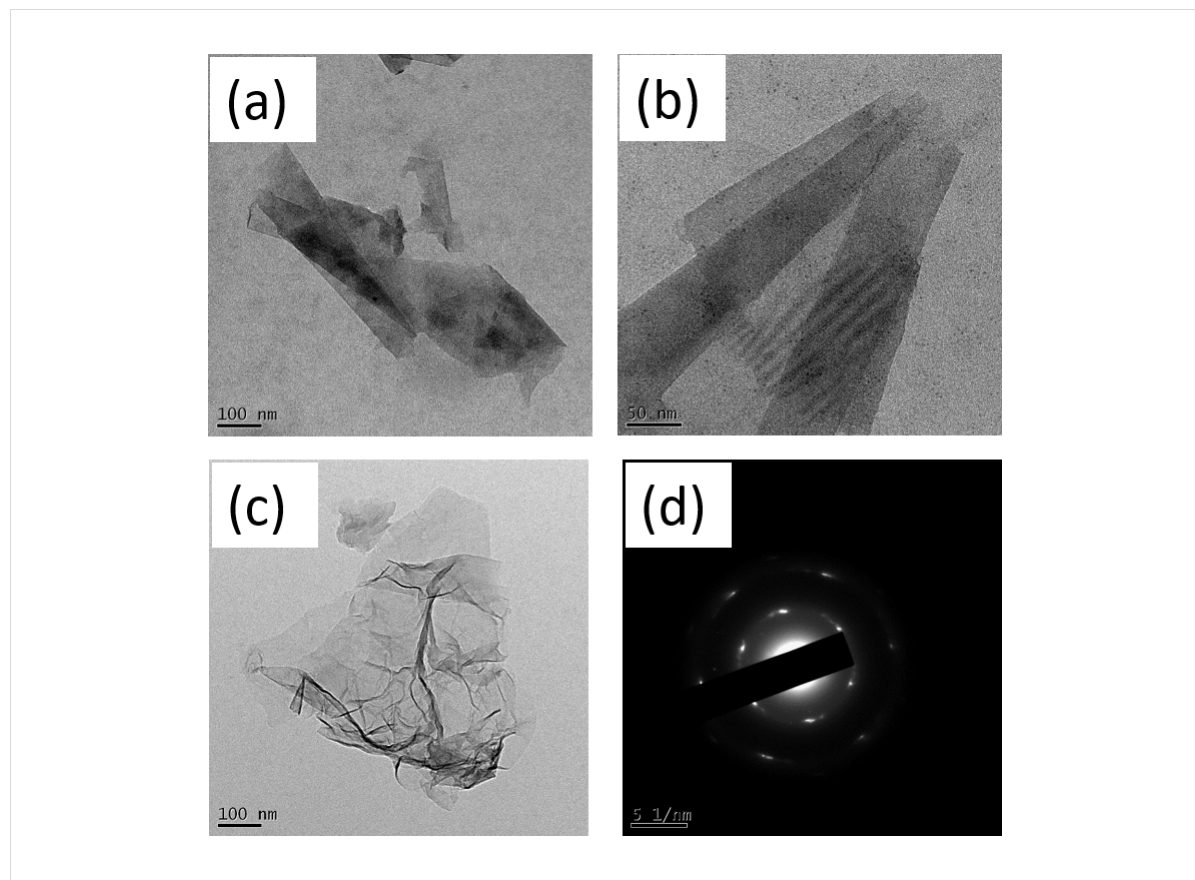
Figure 5: (a, b) TEM images of few-layered graphene partially rolled into nanoscrolls synthesized by irradiating graphite with microwaves in the pres- ence of Zn metal for 30 s. (c) TEM image of graphite oxide after exfoliation trough microwave irradiation in the presence of Zn metal for 30 s and (d) the corresponding selected area electron diffraction